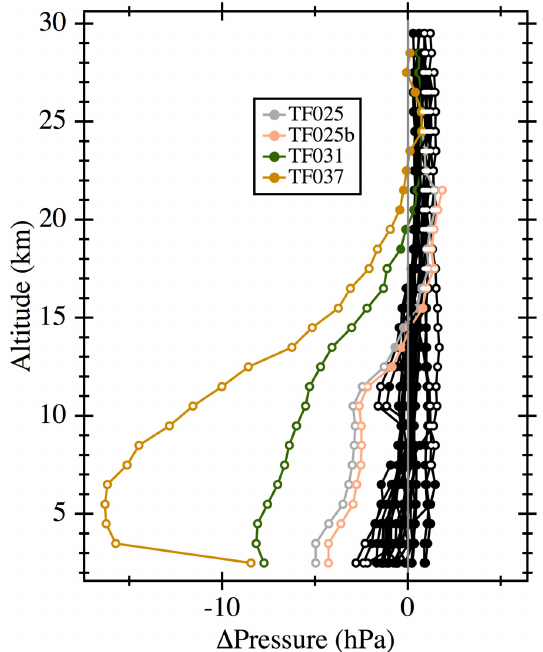
Fig. 5. Statistics of 1T for RS92-iMet (black) and RS92-RS92 (red) in 5-km altitude bins. The mean (dot), median (thick verti- cal dash), inner-68% range (shaded bar), standard deviation range (bounded by two thin vertical dashes) and 5th to 95th percentile range (horizontal line) of 1T for the majority of profiles are pre- sented. In each altitude bin both the standard deviation range and inner-68% range of RS92-iMet 1T do not include zero, reveal- ing statistically significant biases over the entire altitude range. For RS92-RS92 1T both the standard deviation range and inner-68% range of every altitude bin include zero, exposing no significant biases.